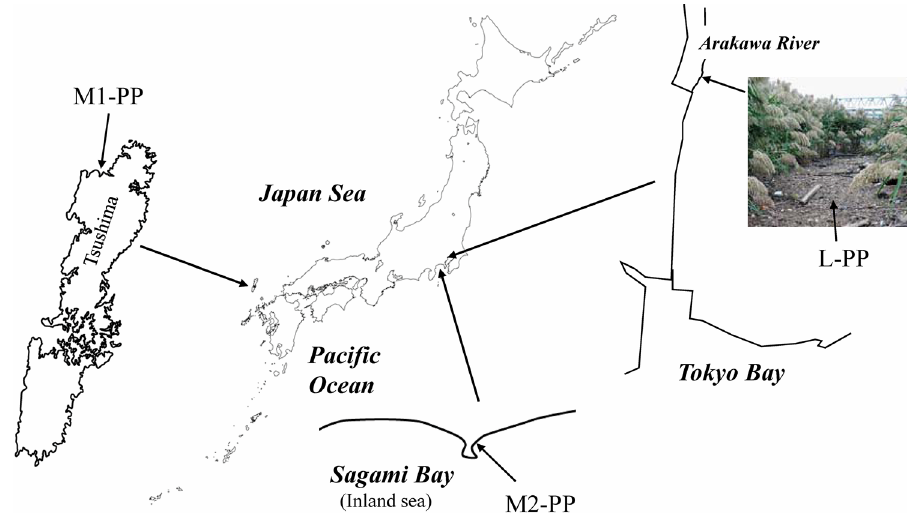
Fig. 1 Sampling locations of M1-PP , M2-PP and L-PP samples. Letters and numbers represent sampling sites, respectively. Local names and other information are given in